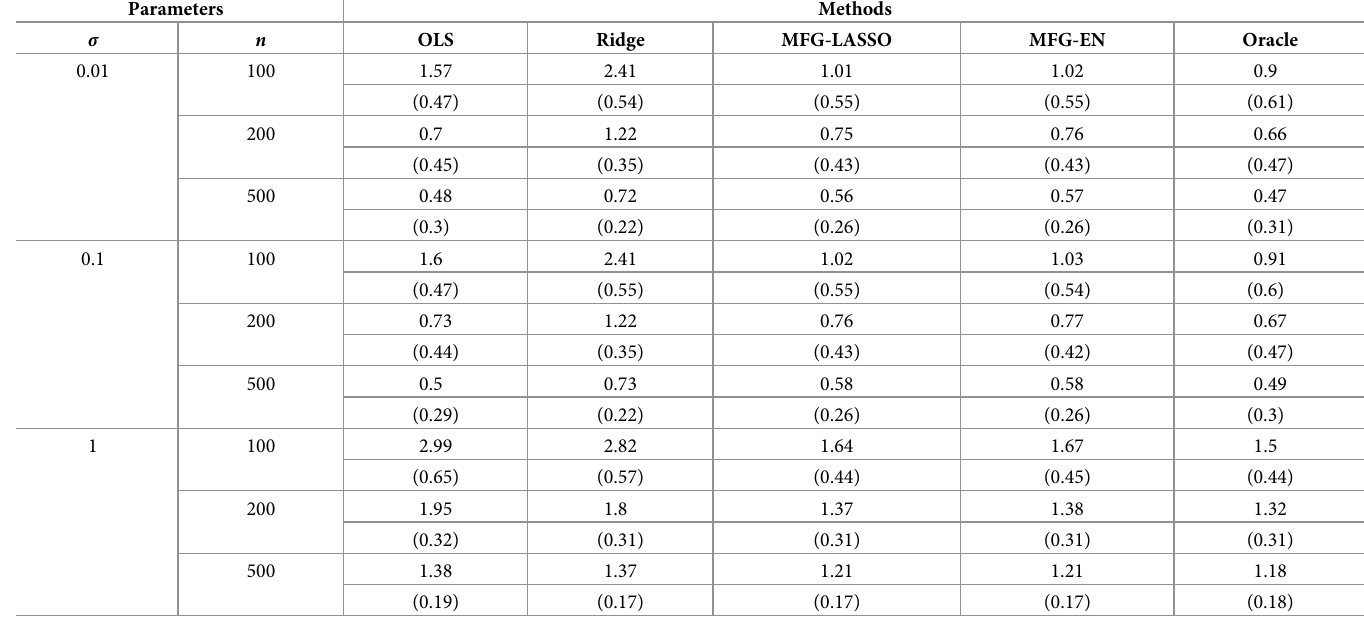
Table 2. Average test RMSE of different methods under different simulation scenarios. In each case, 100 random samples are used to compute the mean and standard deviation with parentheses.